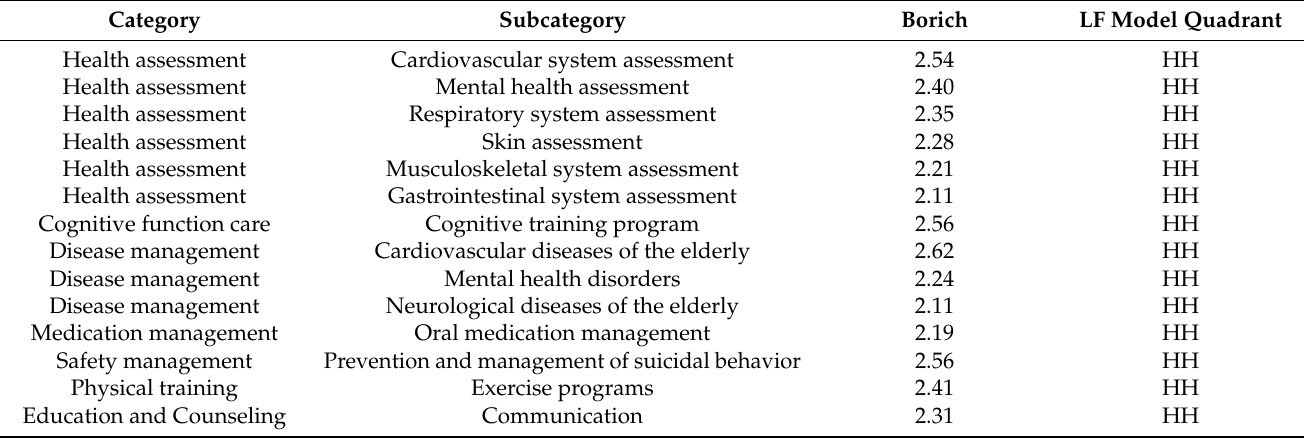
Table 4. Top-priority subcategories for educational needs ( N =